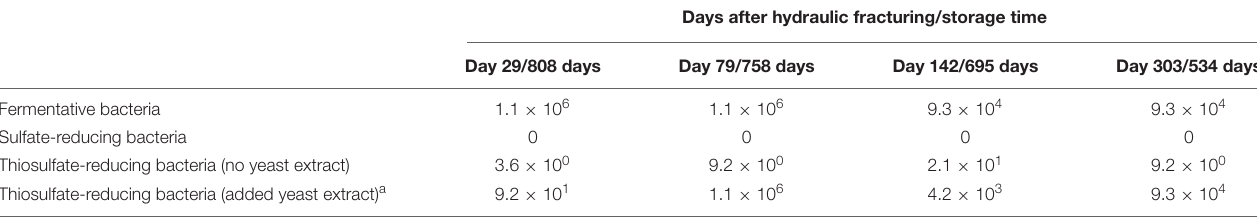
TABLE 1 | Most probable number (MPN) counts (cells/ml) after 112 days incubation and the average cell counts from time of sample